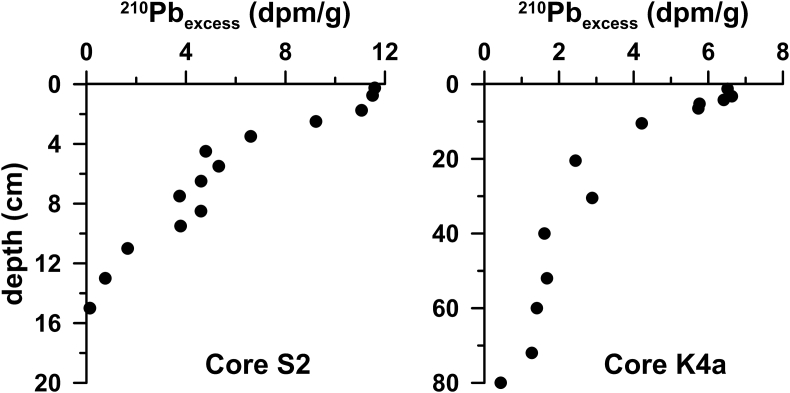
Down-core variation of 210Pbexcess for cores S2 and K4a.